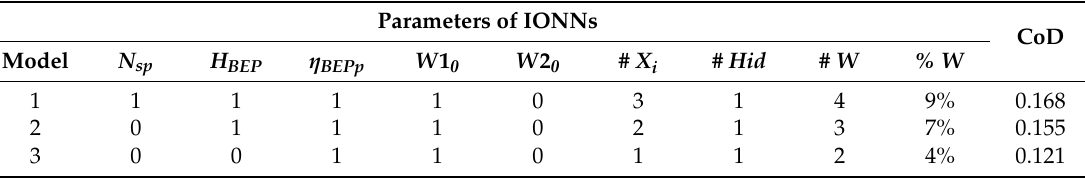
Table 8. Pareto front of IONNs for q for a linear transfer function.